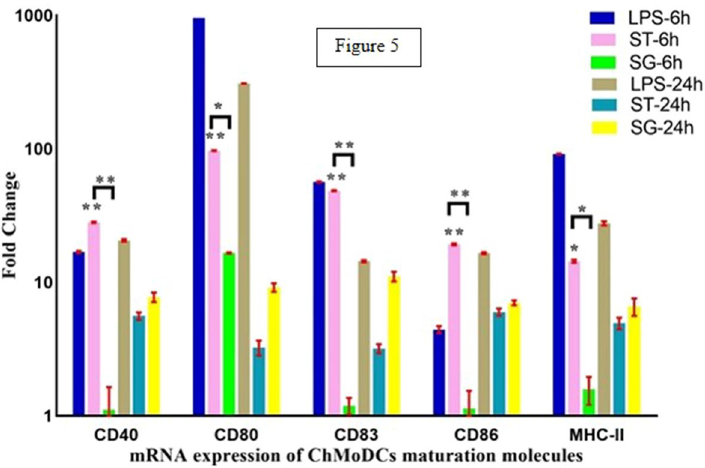
Figure 5. Fold change expression of cell surface molecules on chMoDCs 6 h and 24 h after exposure to S . Gallinarum (SG) and S . Typhimurium (ST) (multiplicity of infection was 10) and Salmonella LPS. The